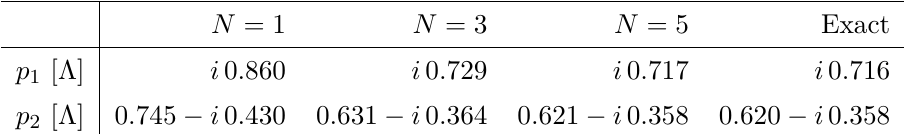
Table 3 . Lightest pole positions in units of Λ = (2 πmM 2 /αγ E ) 1 / 3 of the S -wave PWA T AC for the AC model with v ( δ ) calculated at order δ N , for N = 1 , 3 and 5. The pole positions are compared with the exact result, eq. (7.27), given in the last column. The convergence in the results as N increases is clear. There is a third pole at p 3 = − p ∗